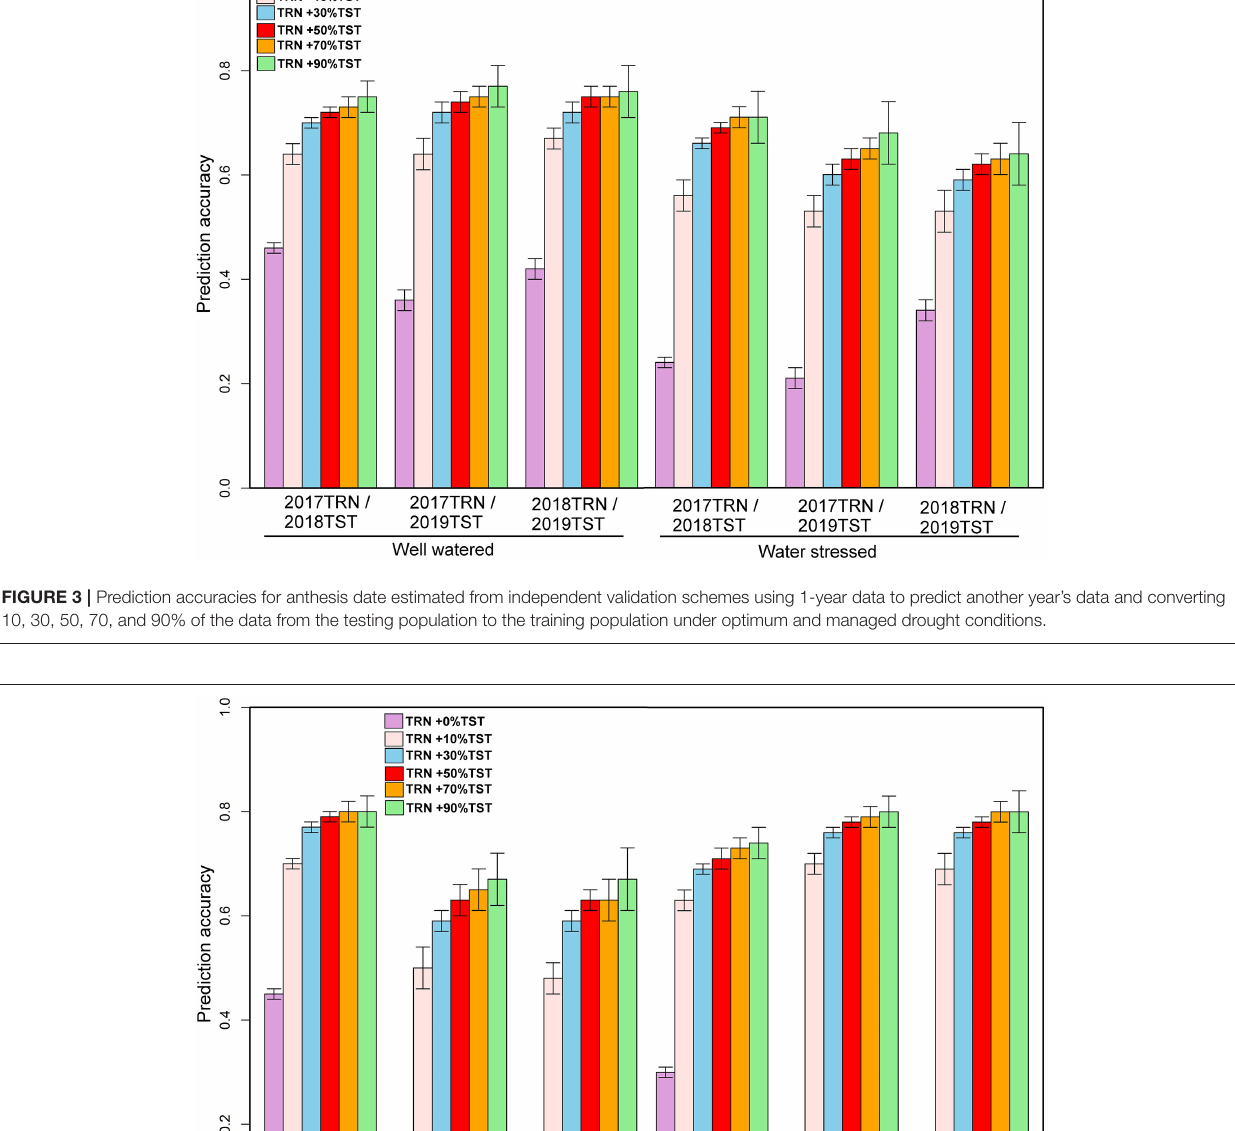
prediction using existing breeding data from previous years to predict untested lines at an early testing stage to bypass the first- year phenotyping stage, saving a year in the process. This